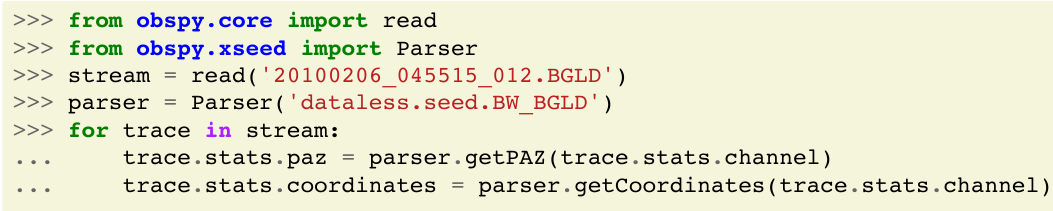
Figure 6. Example code: Reading waveform data and attaching metadata from local files.